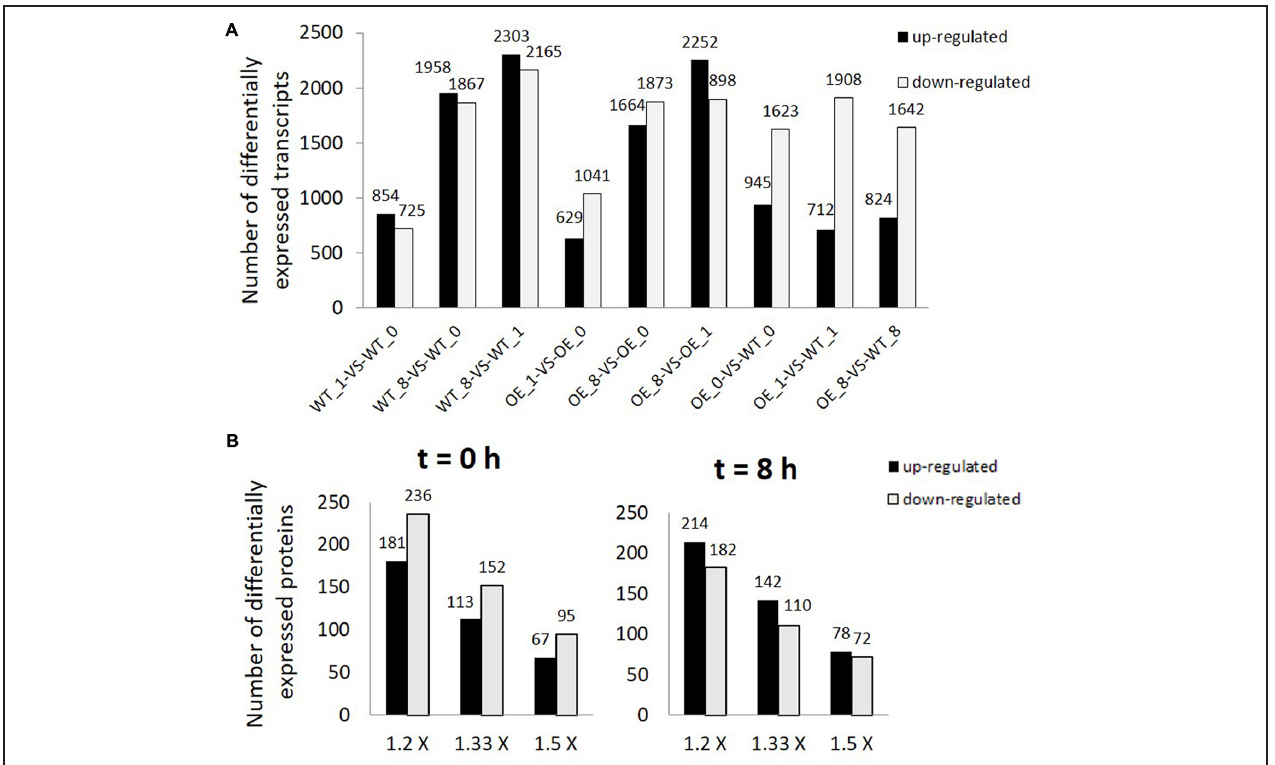
FIGURE 2 | Differentially expressed transcripts and proteins in overexpression (OE) line compared with WT. (A) Number of differentially expressed transcripts (FDR ≤ 0.001, P < 0.001, and FC > 2). WT_0, WT_1, WT_8, OE_0, OE_1, and OE_8 represent WT and OE samples collected at t = 0, 1, and 8 h, respectively. (B) Number of differentially expressed proteins (1.2 × : 1.2 fold change, 1.33 × : 1.33 fold change, and 1.5 × : 1.5 fold change) between OE and WT samples collected at t = 0 (left) and 8 h